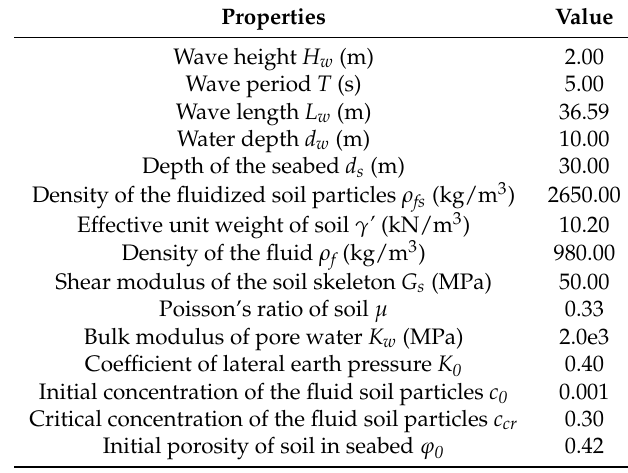
Table 1. Parameters used in the numerical model for the typical wave condition case.